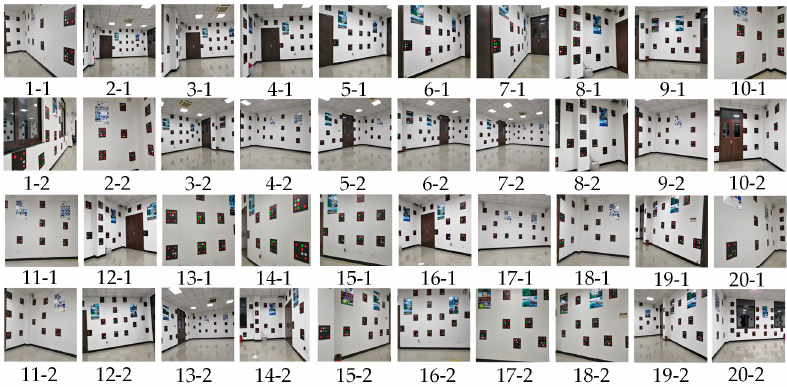
Figure 14. Images of the Huawei P10.